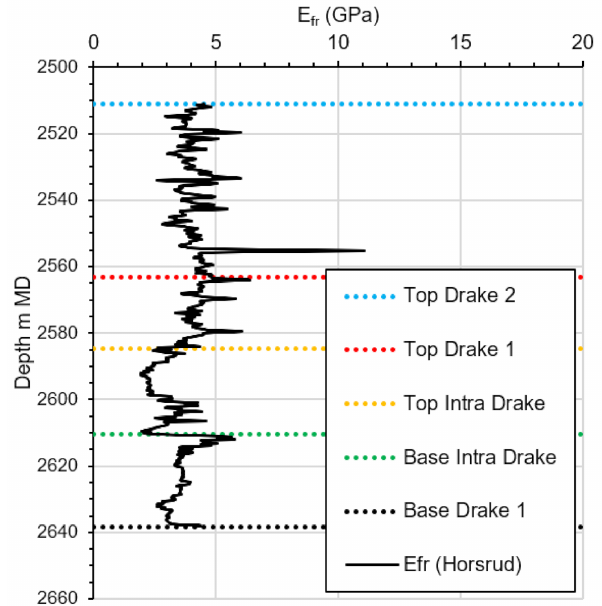
Figure 3. Framework elastic moduli estimations, Drake